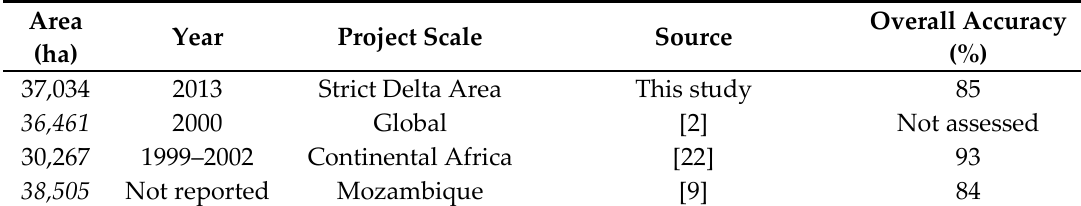
Table 7. Mangrove area within the Zambezi River Delta as reported from recent assessments at varying scales using Landsat data. The comparison is for the area within the Delta boundary as shown in Figure